Question: Condense the content of this figure into a single sentence.
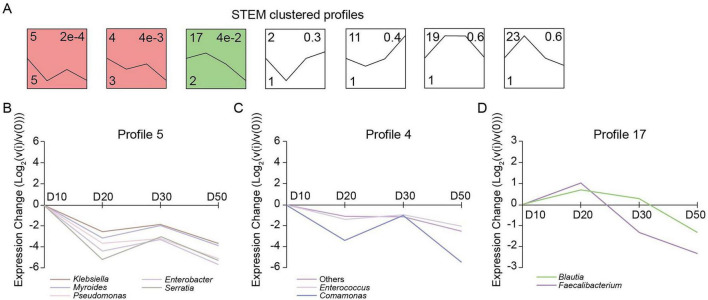
Answer: Short time-series expression miner (STEM) analysis of the changes in abundance of larval intestinal bacterial genera across different population densities. (A) The clustered profiles of change patterns of the larval intestinal bacterial genera using STEM. The colored profiles were significant (FDR < 0.05). The numbers in the top left corner, top right corner, and bottom left corner represent the module ID, significance values, and number of included genera, respectively. (B–D) The expression changes of bacterial genera in the significantly clustered profiles 5 (B) , 4 (C) , and 17 (D) . The v(0) and v(i) represent the abundance of bacteria genera at the population density of 10 and i individuals per tube, respectively.